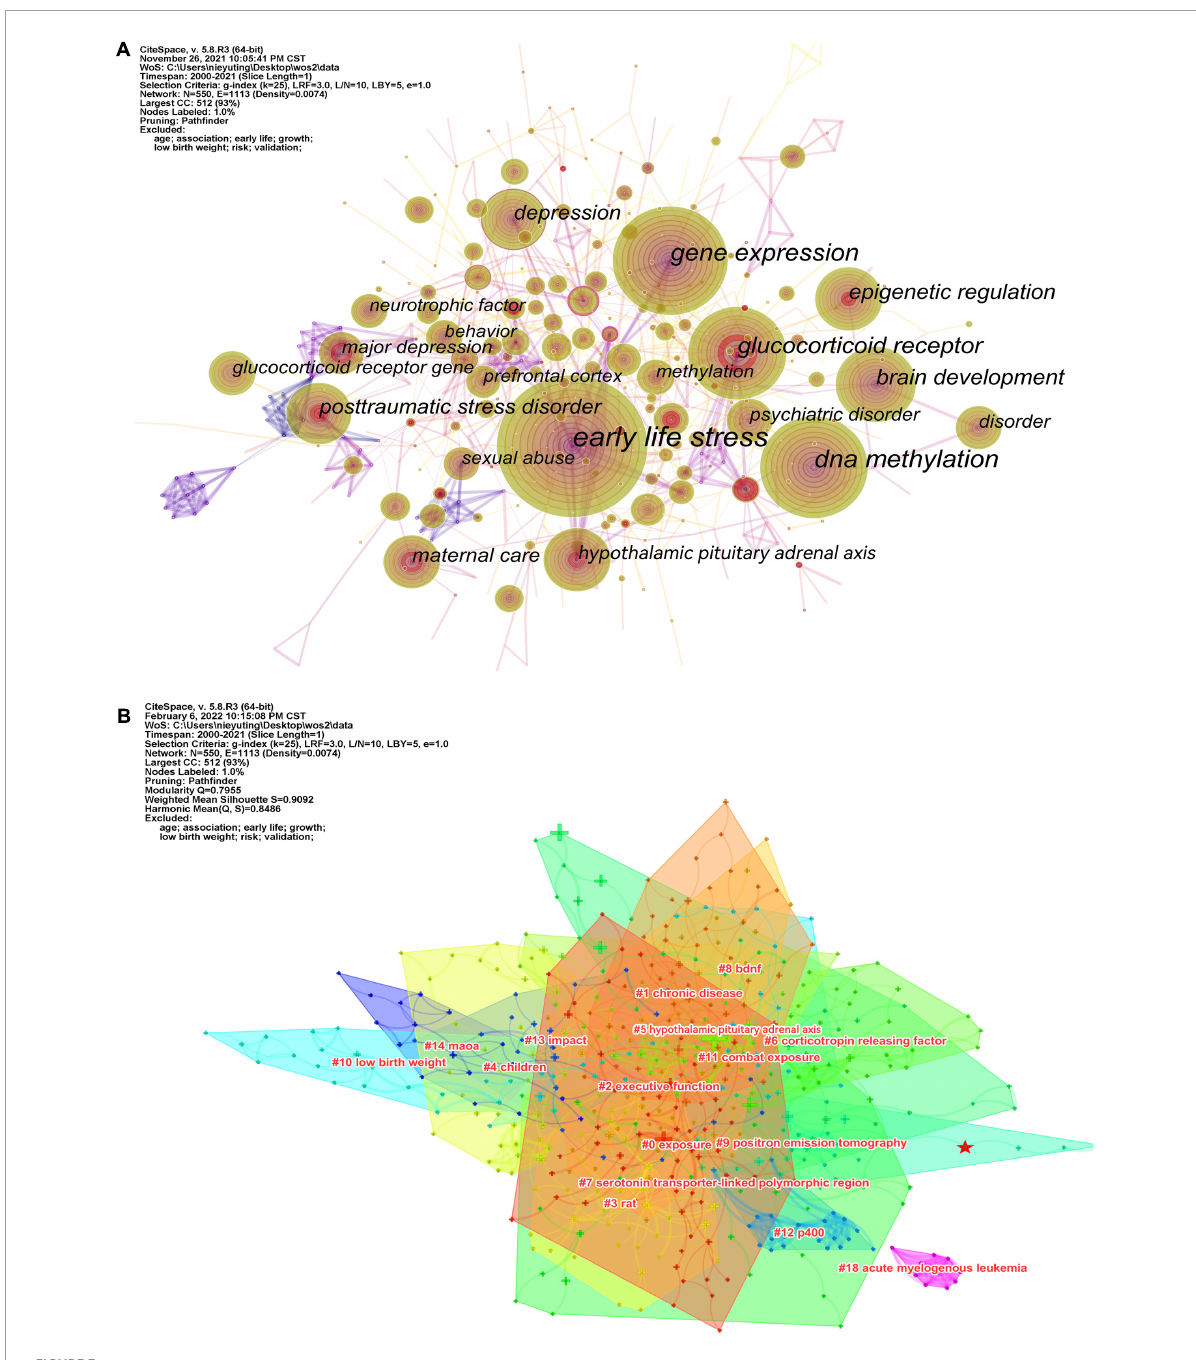
FIGURE3 (A) Visualization of the keyword co-occurrence network. (B) Cluster analysis of keyword networks.